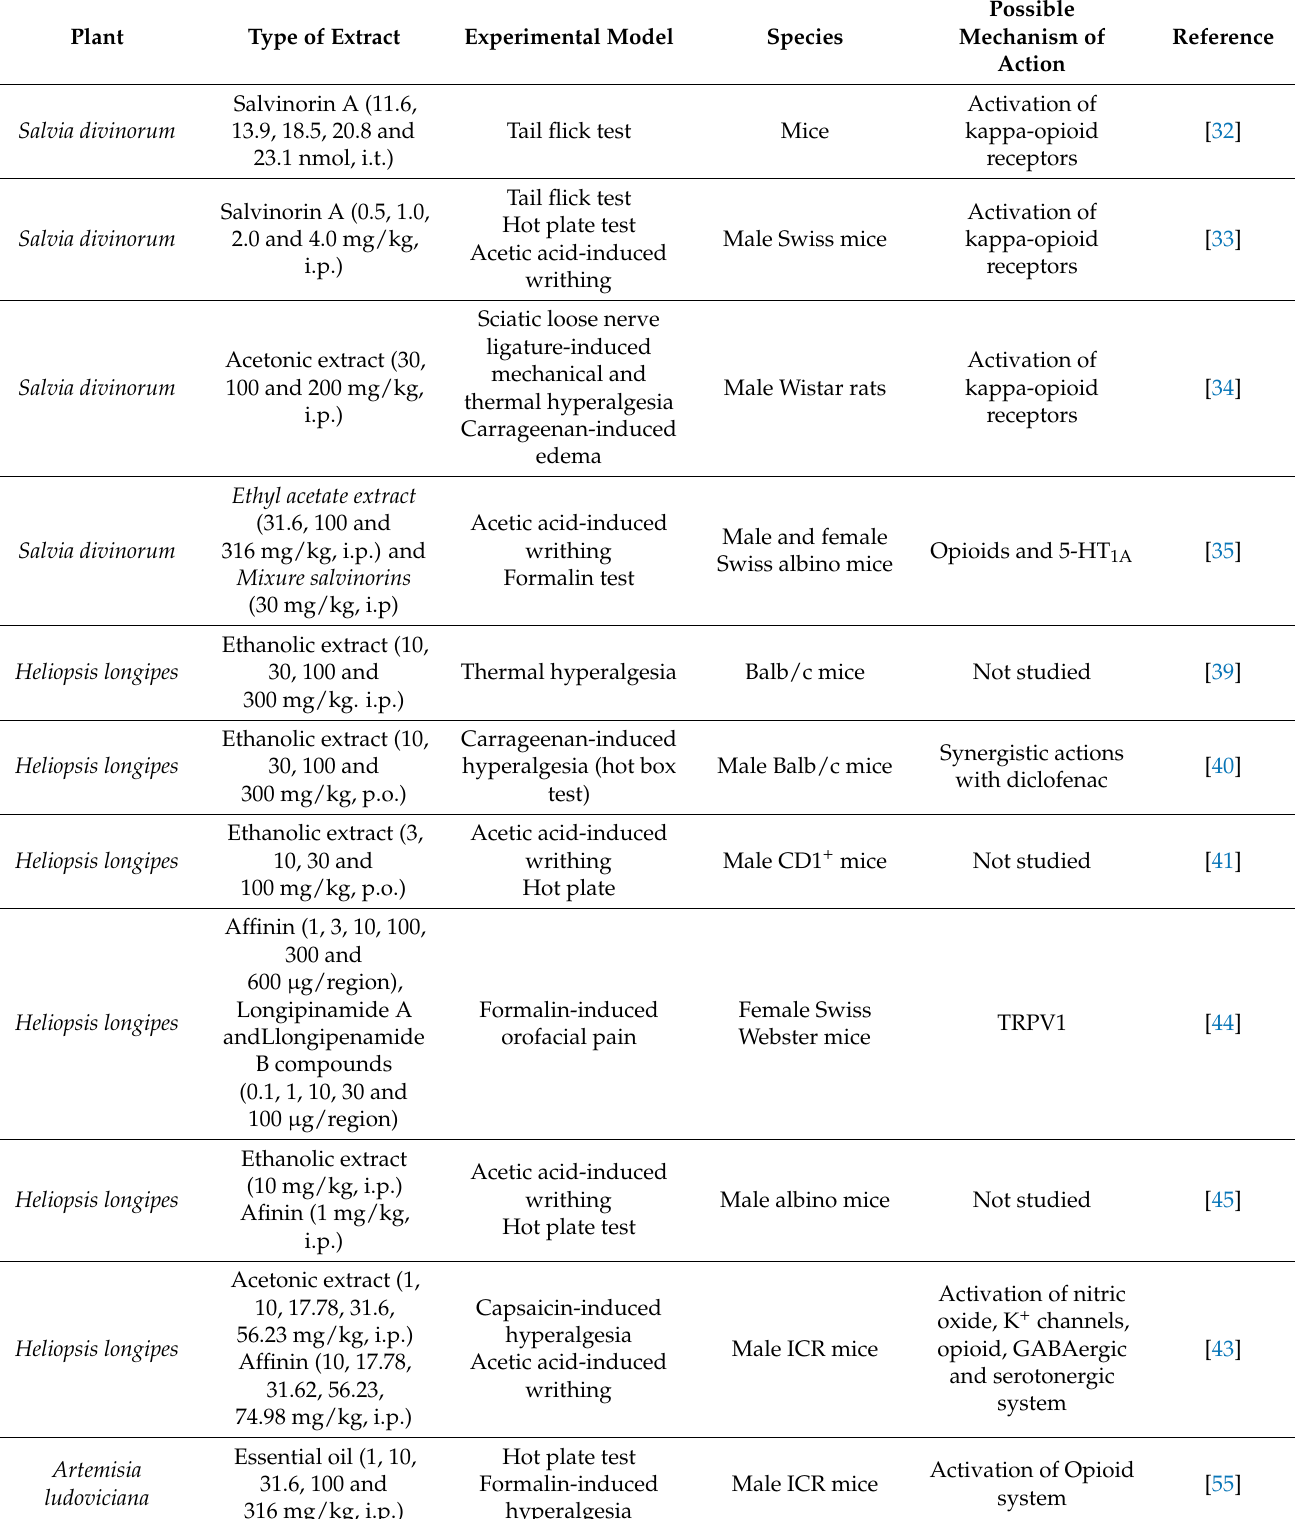
Table 1. Mexican medicinal plants and their antinociceptive effects. This table contains a summary of preclinical studies with medicinal plants, as well as the possible mechanisms of action that underlie their antinociceptive effects.